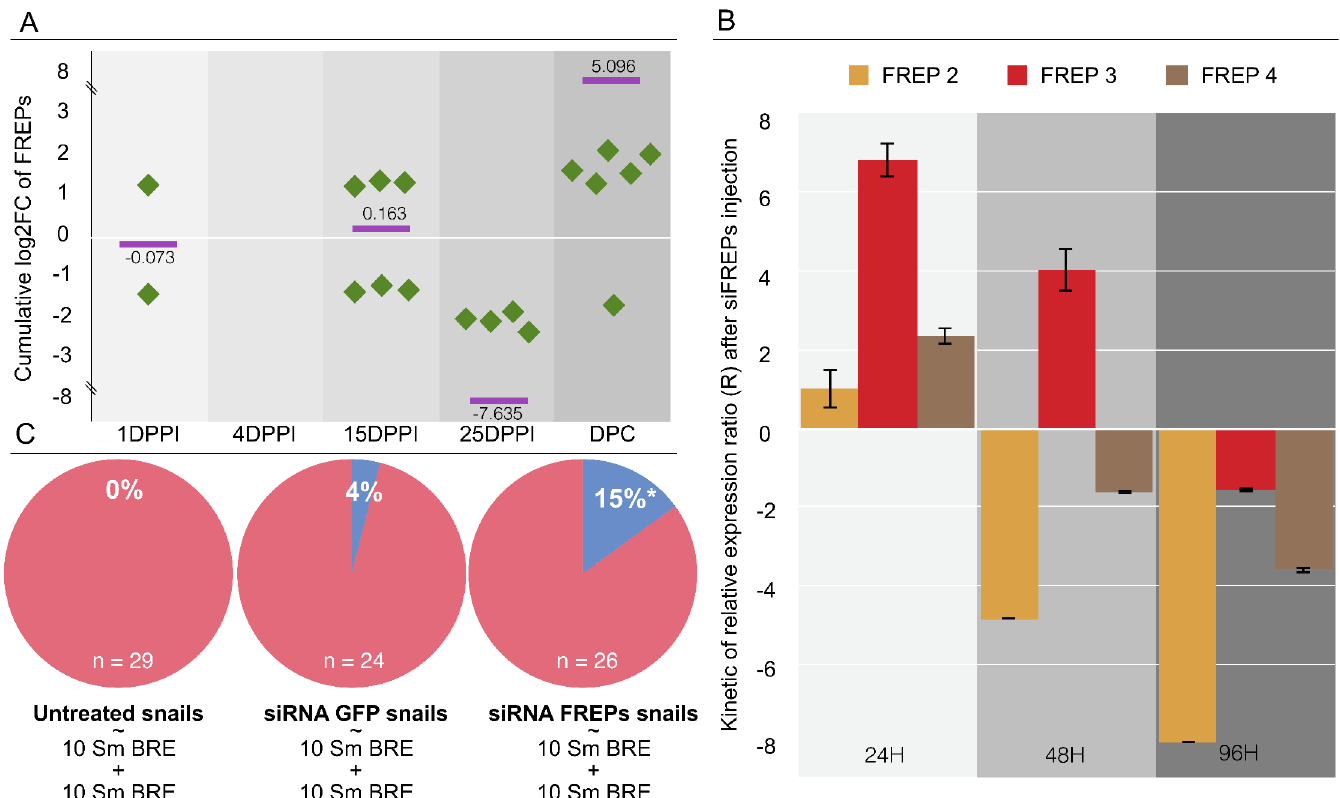
Fig 4. FREPs knock-down mediated by RNA interference. A. Cumulative expression [Log2FC (fold change) from the DESeq2 analysis] of FREP transcripts showed that FREPs were over-represented after the secondary challenge (DPC; 5.096 log2 fold change enrichment of FREPs transcripts). Green points corresponded to the differentially represented FREPs transcripts in each samples. Purple bars represent the cumulated Log2FC of FREP transcripts. At 4DPPI no FREP transcripts were differentially expressed, thus no value appeared in the graph. B. siRNA injection against FREP2, FREP3 & FREP4 was carried out and mRNA abundance was monitored during 4 days by Q-RT-PCR. Snails were injected with siRNAs against FREP 2, 3, and 4 or GFP (control), the relevant mRNA levels were assessed following normalization with respect to the S19 gene in siGFP injected snails versus siFREPs injected snails. Knock-down of the three FREPs tested was confirmed at 96h. C. Na ï ve B . glabrata and siFREP-injected snails were subjected to a typical priming experiment: Snails were infected with 10 miracidia of S . mansoni as a primo-infection, 21 days later they were injected with siGFP, or SiFREP or not treated and 4 days later they were infected with another 10 miracidia as a secondary challenge. FREP siRNA-injected snails show a significant proportion of non- primed snails (15%; * , binomial test, P <